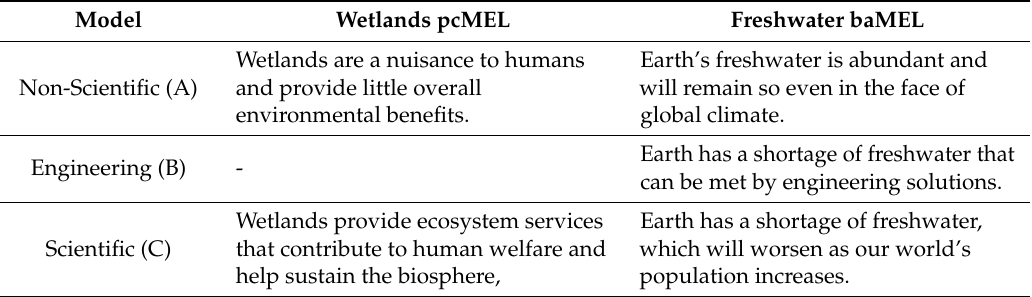
Table A2. Models for both pcMEL and